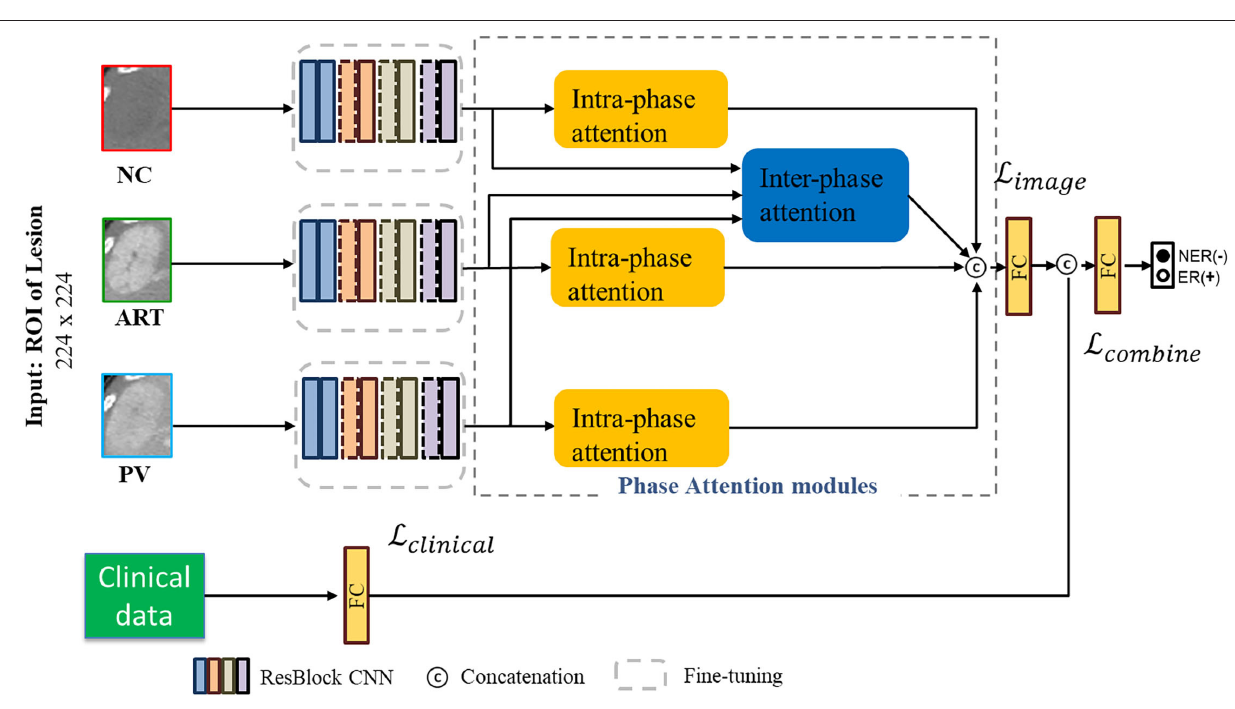
channel again. Then, the spatial attention feature was generated by the sigmoid function, and the feature was multiplied by the original feature map. The final feature was obtained by summing up the features generated by the channel attention and spatial